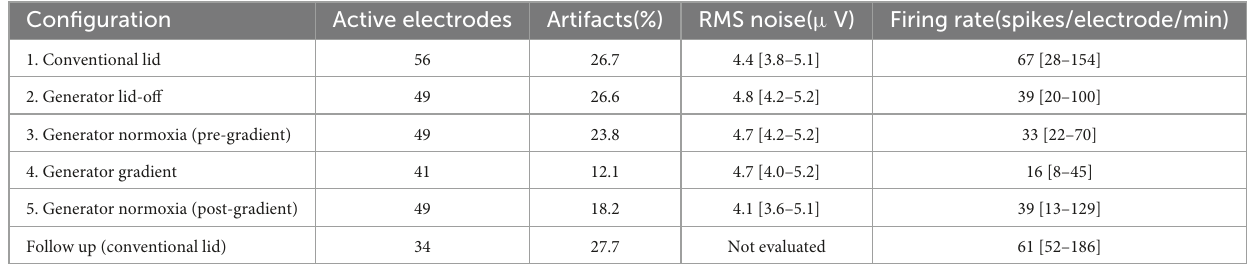
TABLE 1 Main electrophysiology readouts evaluated for each